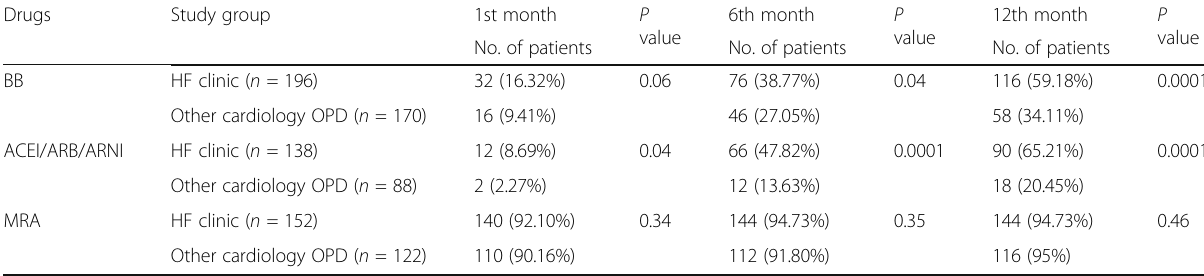
Table 2 Comparison of target dose achievement in HF clinic and other cardiology OPD